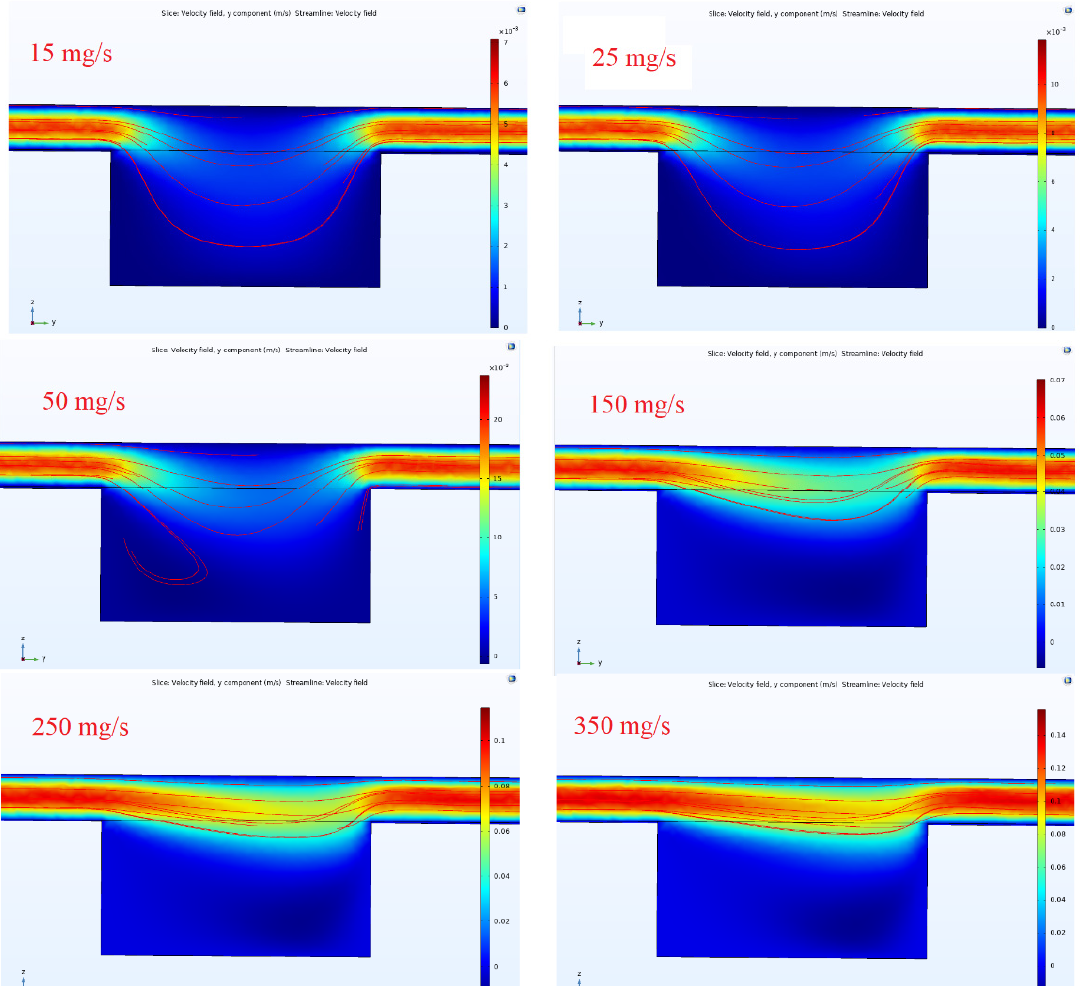
Figure 17. Velocity contours for different values of inlet mass flow rate in the microfluidic channel.